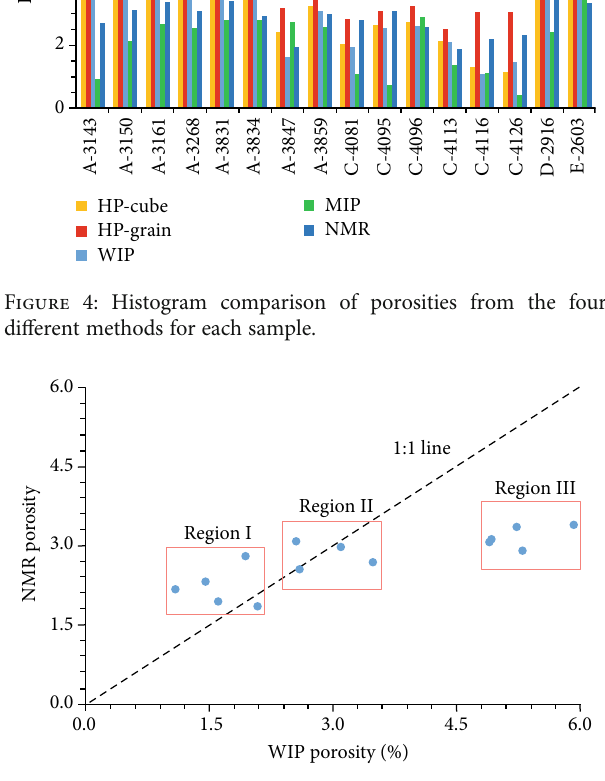
Figure 5: Comparison of porosities from WIP and NMR measurements. Three regions are divided according to absolute di ff erence between porosities from two methods.